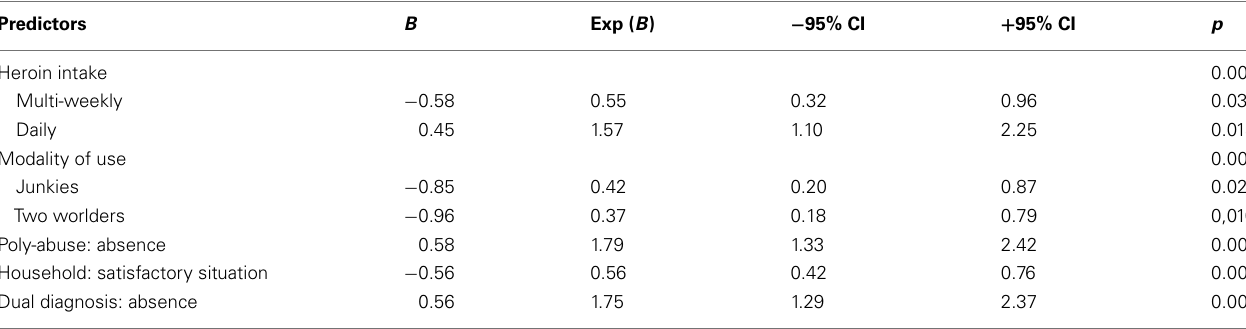
Table 4 | Predictors of